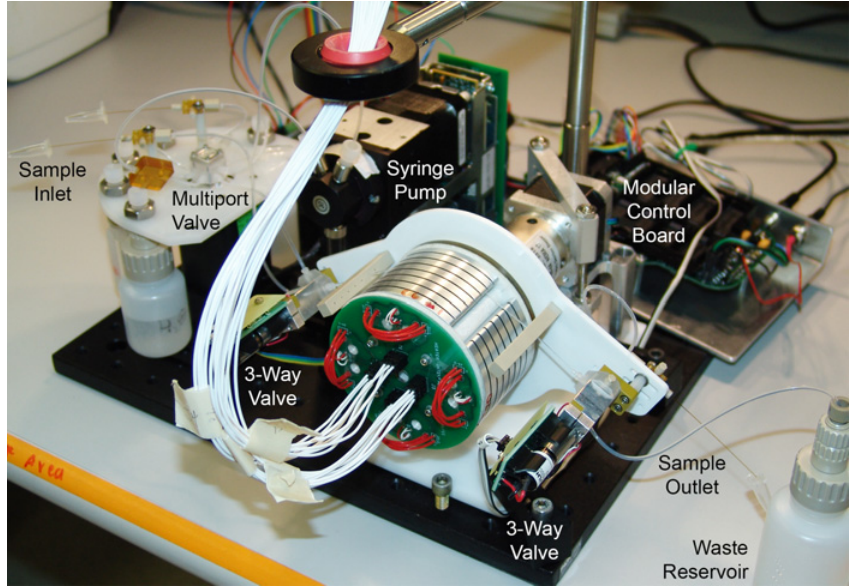
Fig 4. Integrated rotary zone PCR system corresponding to the schematic of Fig. 3. The wheel is oriented horizontally with the wire harness for heater power and temperature sensor measurements routed upward to the four-channel Omega controller box (Fig. 5B) on a shelf above the system. The sample capillary is tensioned against the upper part of the RZTC wheel by Sandia TubeTite connectors at the three-way valves upstream and downstream of the heated zone. Not visible in the photo are the Keyspan serial hub and RS485 converters behind the syringe pump. doi:10.1371/journal.pone.0118182.g004 valve is switched and the air and sample are pushed into the reactor. The valve is switched back to the inlet and the air which preceded the sample during aspiration is pushed out until only 2 μ L remain upstream of the valve. The valve is switched to the wheel and the trailing air bub- ble with water behind it is pushed into the reactor until the sample is centered over the heater